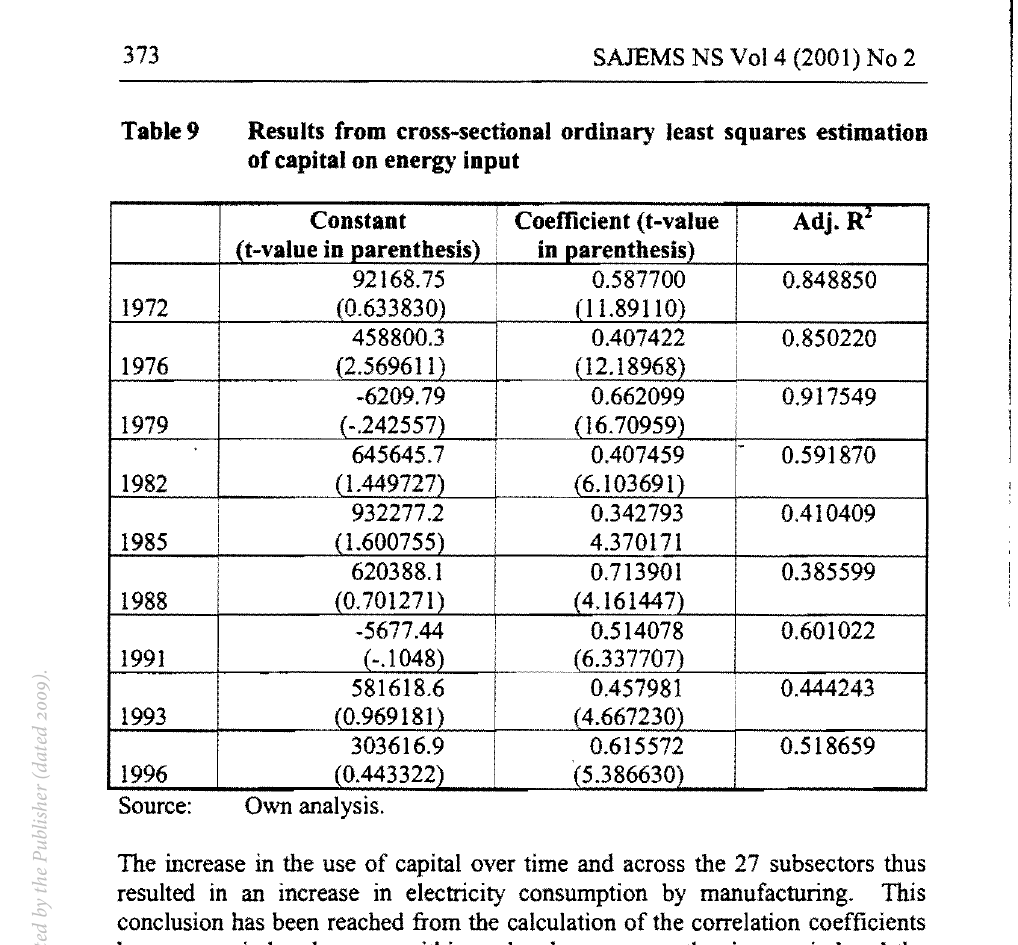
Results from cross-sectional ordinary least squares